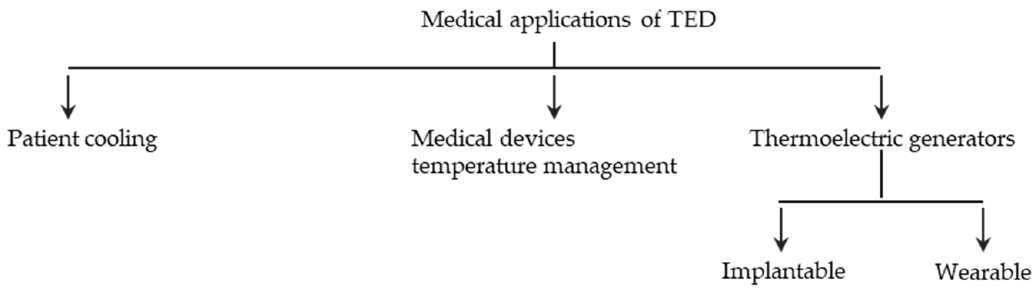
Figure 12. Classification of TED in medical applications.